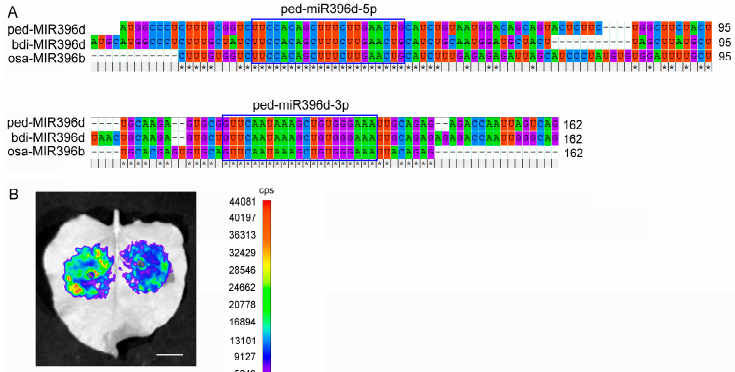
Figure 5. The correlation of three miR396s with a putative PeGRF6 analyzed by dual‑luciferase re‑ porter and transient expression assays. ( A ) Alignment of precursor sequences of miR396d from rice, bamboo, and Brachypodium distachyon . Sequences of bdi‑miR396d and osa‑miR396d from B. dis‑ tachyon and rice, respectively, were downloaded from the miRBase; ( B ) Fluorescence intensity of the same leaf injected with an empty vector (EV) + PeGRF6 at one side and with miR396 + PeGRF6 at the other side, indicating the binding of miR396 to PeGRF6 . Bar = 1 cm.